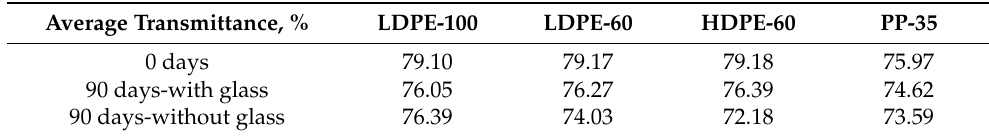
Table 2. Average transmittances in the atmospheric window.